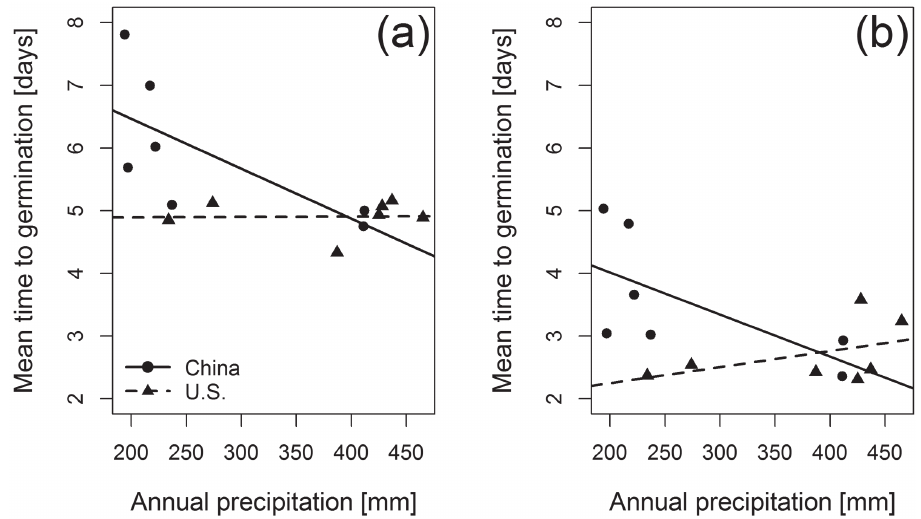
Figure 4. Relationship between mean time to germination and annual precipitation per Ulmus pumila population ( a : 20°C/10°C; b : 32°C/20°C). To emphasize the different responses between the two ranges (non-native range: triangles; native range: circles), trend lines per range are shown (non-native range: dashed line; native range: solid